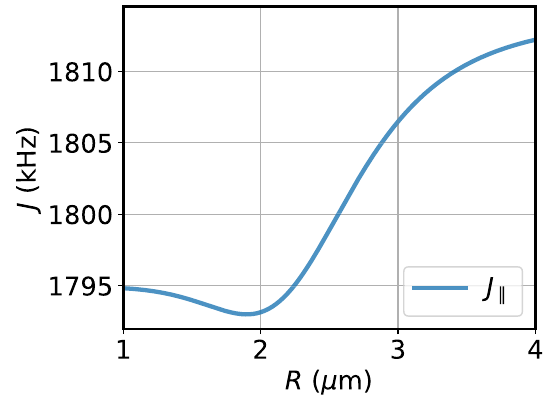
FIG. 12. The alternative effective magnetic field.